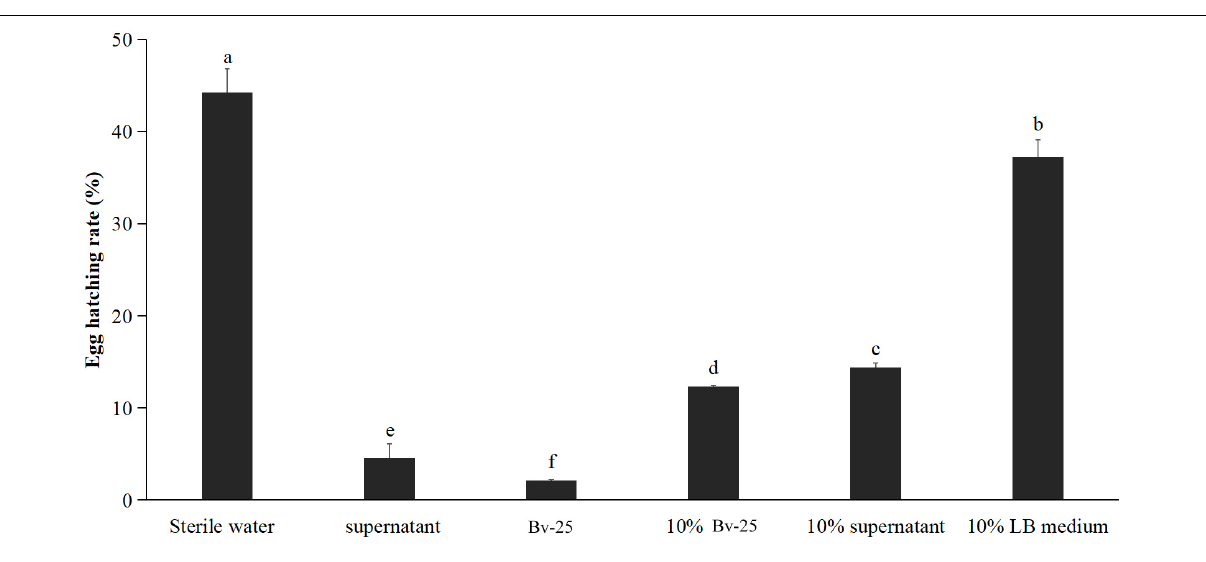
FIGURE 2 | Strain Bv-25 inhibited the hatching of M. incognita eggs in vitro . Egg-hatching rates were evaluated by treating 150 eggs with the Bv-25 fermentation broth, 10% fermentation broth, supernatant, and 10% supernatant for 72 h at 28 ◦ C. The negative control was sterile water. Different letters indicate significant differences ( p < 0.05; n = 30) between treatments according to Duncan multiple-range test following one-way